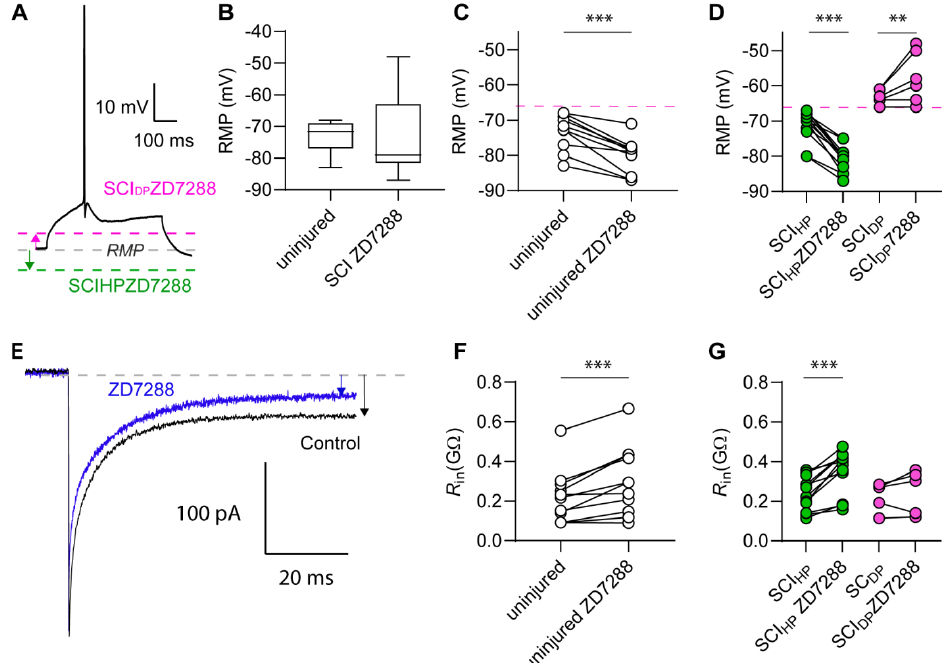
Figure 3. Heterogeneous effects of HCN channel blockage in M1LV neurons after SCI. ( A ) The RMP of uninjured and axotomized neurons is monitored in current clamp experiments at baseline voltage before the application of current steps that elicit AP firing. ( B ) Application of ZD7288 has a rescuing effect on the RMP of axotomized neurons, which is no longer significantly different from the RMP of uninjured neurons. ( C ) ZD7288 causes significant RMP hyperpolarization in uninjured neurons. ( D ) ZD7288 causes RMP hyperpolarization in axotomized neurons (SCI HP ), of which the RMP was originally < − 66 mV (red line). Conversely, ZD7288 causes RMP depolarization in neurons